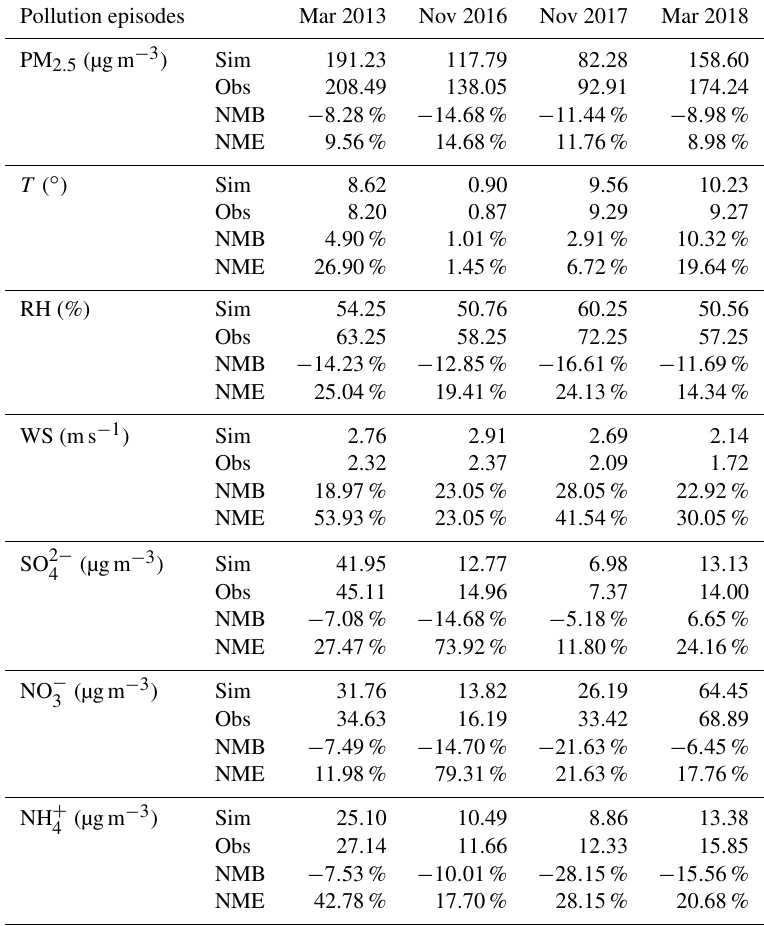
Table 2. The verification of WRF-CAMx performance in terms of meteorological factors, PM 2 . 5 concentrations and PM 2 . 5 components.